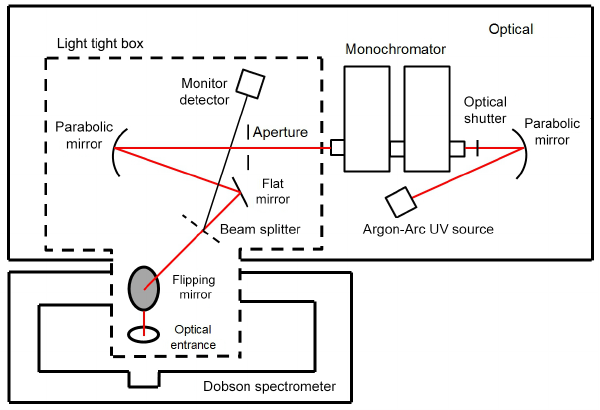
Figure 2. Schematic diagram of CMI monochromator-based facility used for characterisation of Dobson 074.